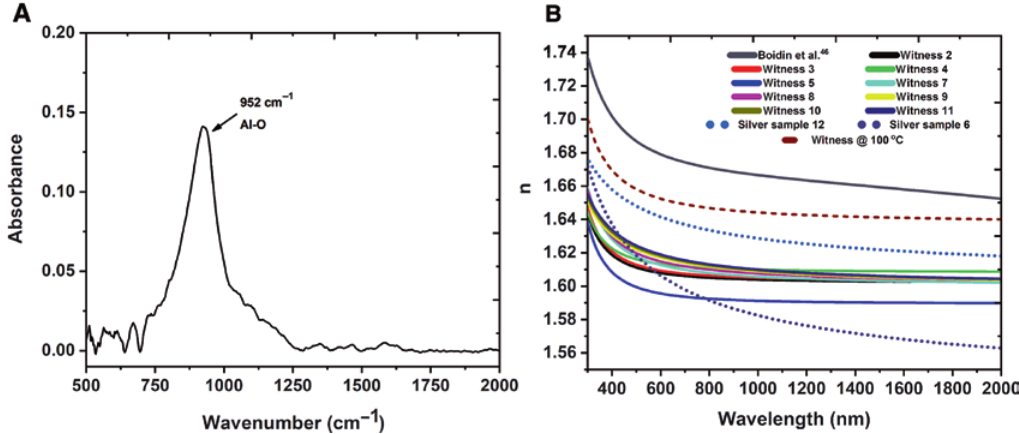
Figure 6: Alumina film measurements. (A) FTIR measurement of a coloured silver sample covered with an alumina film deposited by ALD. The peak at 952 cm − 1 can be attributed to Al-O vibrations. (B) Plot comparing the refractive index of amorphous Al deposited films measured by ellipsometry on the witness silicon wafers and the two silver samples. The difference in the refractive index is attributed to the low-temperature deposition of the alumina film producing lower density and porous